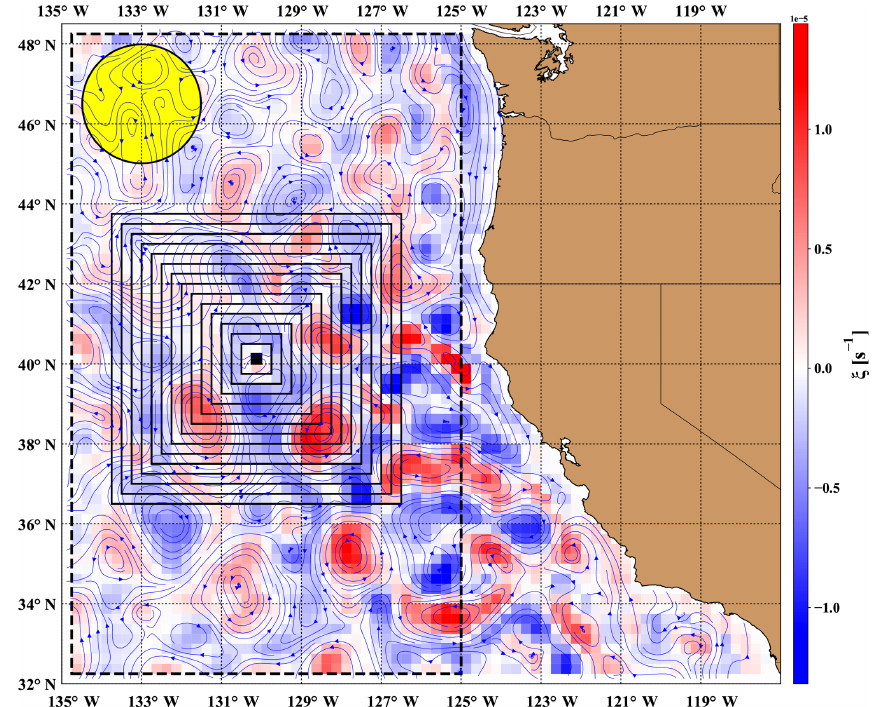
Figure 4. Visualization of the geostrophic flow field on the same day as in Fig. 1 (13 October 2013) from the data set over the US west coast by Risien and Strub (2016). Empirical vertical vorticity ( ξ ) is color coded; blue stream lines indicate flow directions. The color mesh illustrates the spatial resolution well. The heavy dashed frame indicates the offshore region, where the integrated quantities in Fig. 3 are determined, and the yellow circle demonstrates the size of the hypothetical “super-vortex” related to mean vortex statistics on the given day over the offshore region (see text). Black squares illustrate the first 15 growing integration frames centered at the location 40.125 ◦ N, 130.125 ◦ W (see Fig.